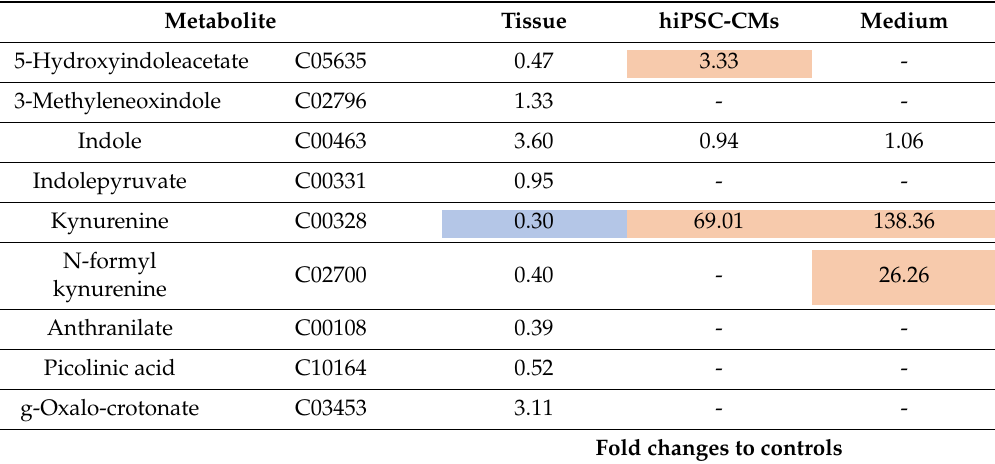
Table 1. Comparison of the metabolome profile of cardiac tissue in comparison to human induced pluripotent stem cells di ff erentiated into cardiomyocytes (hiPSC-CMs) for indole and tryptophan metabolism. Accession numbers are indicated according the KEGG Metabolome Database [43].